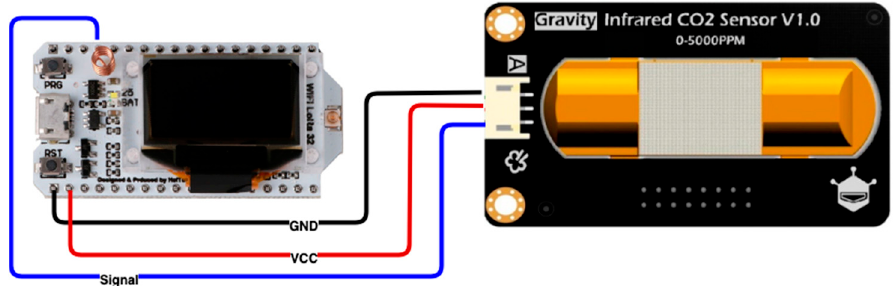
Figure 2. Cyber-physical system.